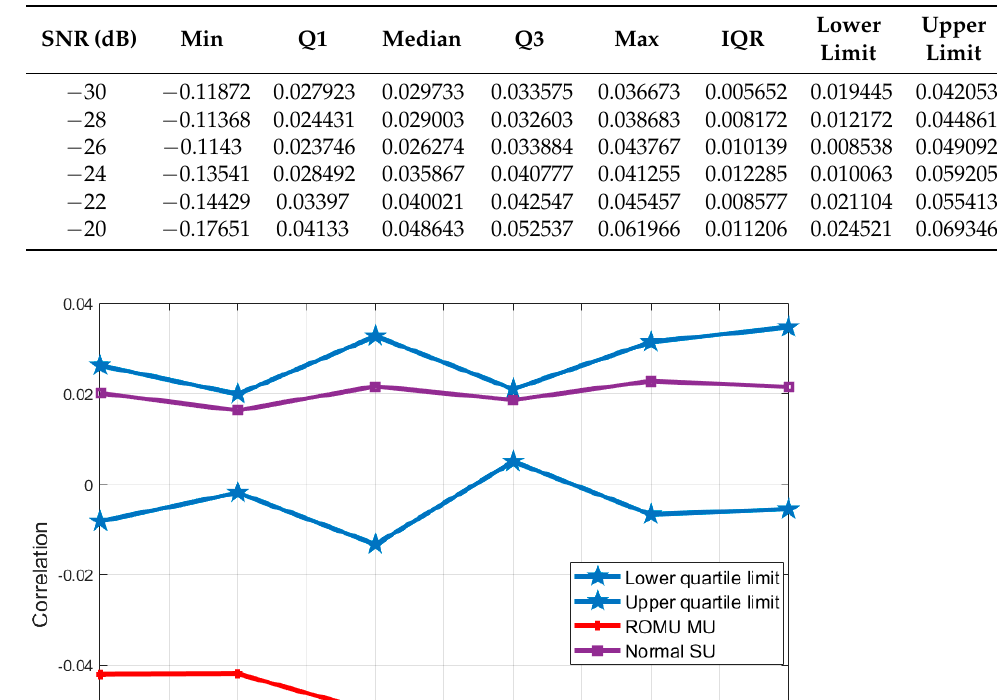
10 of 14 Table 2. Box-whisker plot data of the correlation results under OMU users only.